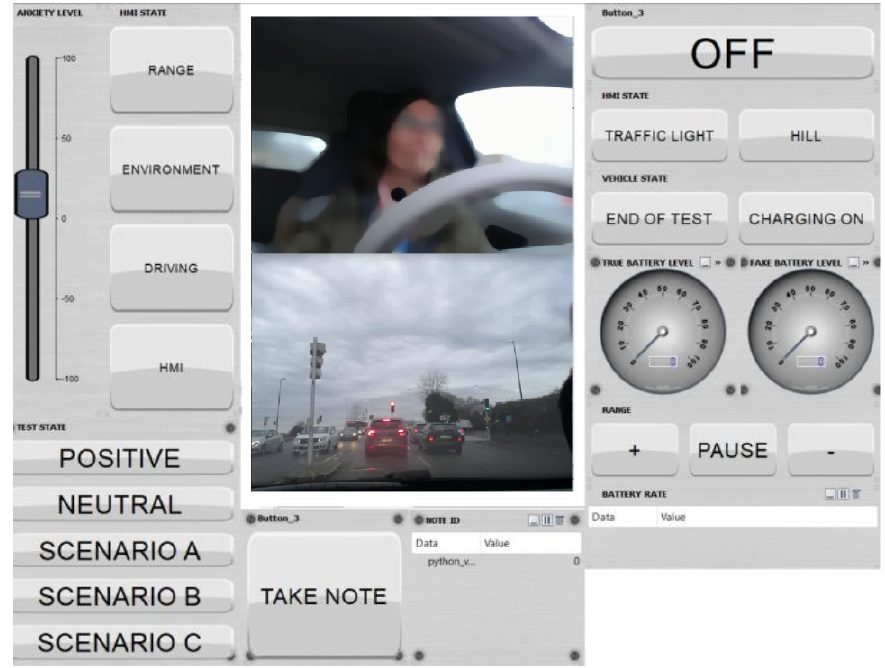
Figure 4. Human–Machine Interface (HMI) note-taker is an in-vehicle live annotation tool. This tool was used to pilot the main HMI and a annotate perceived driver